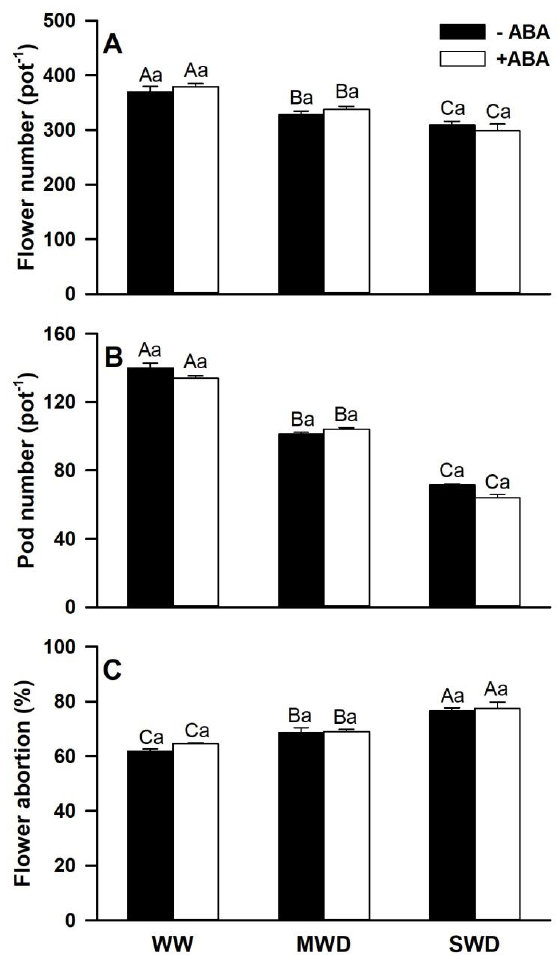
Figure 8. ( A ) Flower number (pot − 1 ), ( B ) pod number (pot − 1 ) and ( C ) flower abortion (%) in the soybean cultivar Jindou 19 (JD)—with and without 10 µ M exogenous ABA applied one day before withholding water—at 45 days after sowing (DAS) under three water treatments (well-watered (WW): Soil water content (SWC) maintained at 70–90% field capacity (FC); moderate water deficits (MWD): 45–55% FC and severe water deficits (SWD): 30–35% FC). Values are means ± SE ( n = 7). The capital and small letter indicated significantly di ff erent among the water treatment at the same ABA level and between the ABA treatment at the same water treatment at p = 0.05,